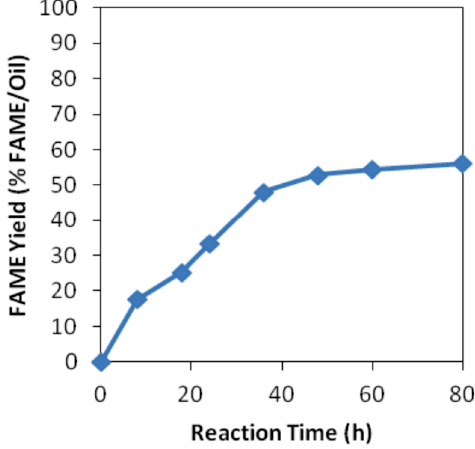
Fig. 7. Time course of FAME yield (0.28% lipase and 72 h reaction).